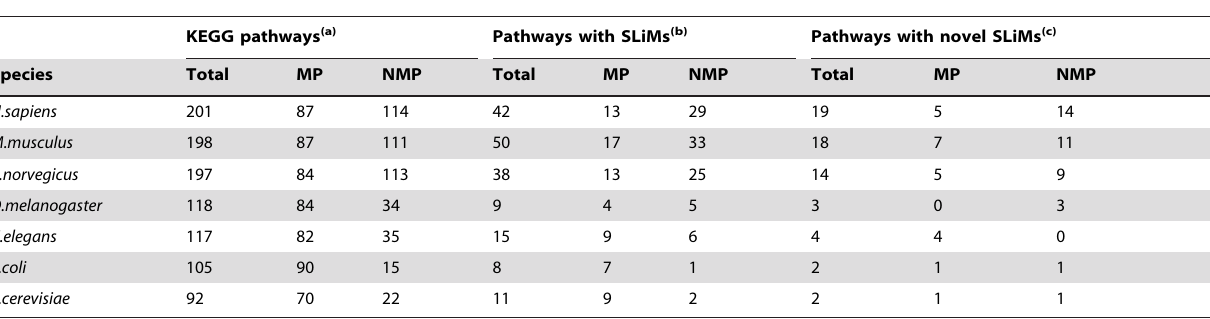
Table 2. Number of KEGG pathways (total and with motifs).